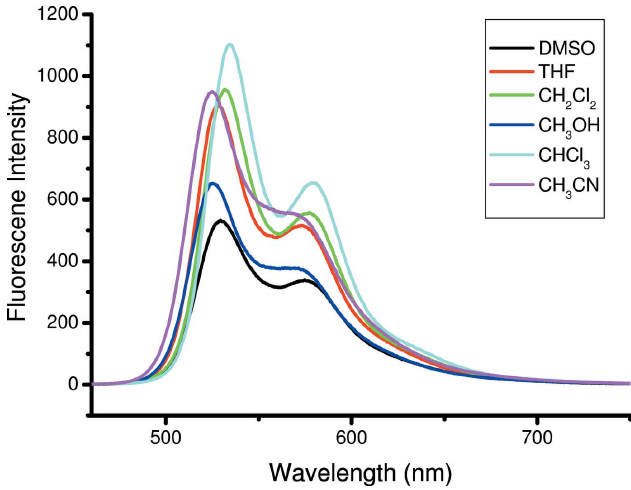
Figure 5 Fluorescence spectra of the title compound in different solutions (1 (cid:6) 10 (cid:3) 5 M